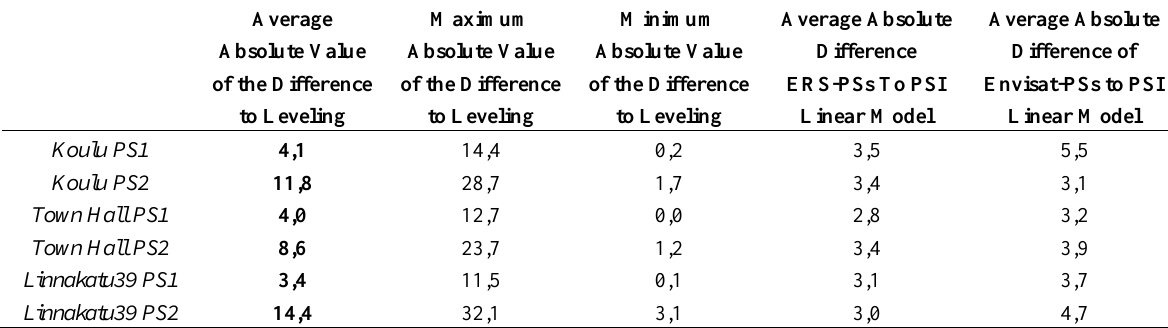
Table 6. Absolute difference of the single PS observations to the linear model based on REDT leveling observations in Figure 7. In addition, the difference of single ERS PSs and ENVISAT PSs to linear model based on the PSI data is